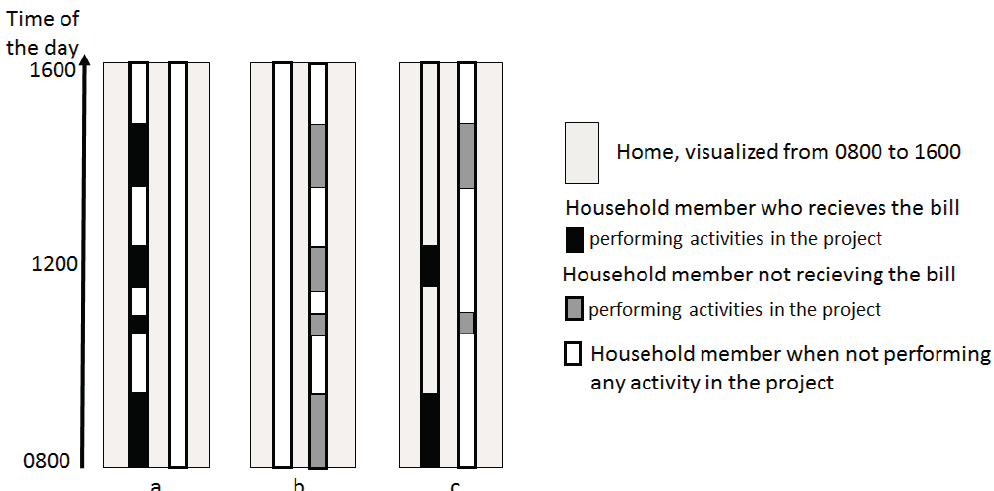
Figure 4. Patterns of division of labor in performing activities in 2-person households in a project with different consequences for household energy conservation